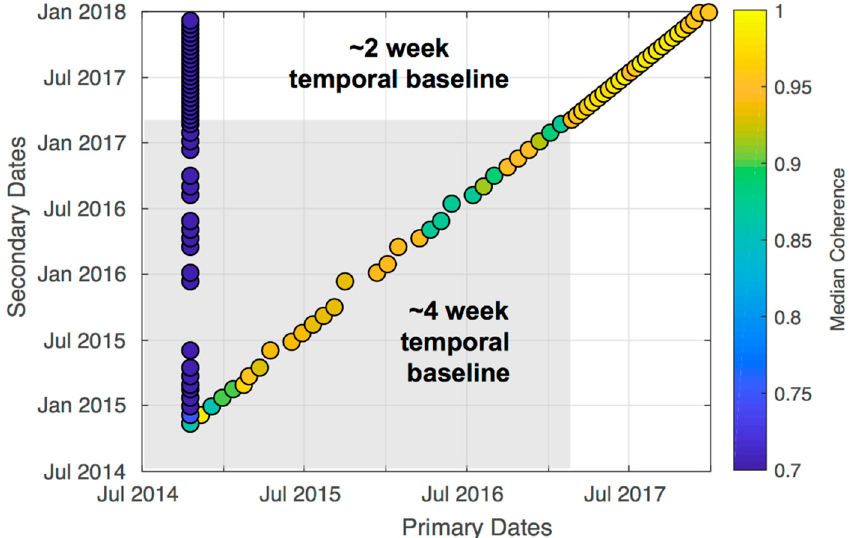
Figure 8. Coherence values averaged over the entire region of interest for all date combinations used in the Quebrada del Toro case study. Though interferometric coherence in images where the temporal spacing is larger, coherence values since the launch of Sentinel1-B have been generally high and will, going forward, result in more robust time series than presently available.